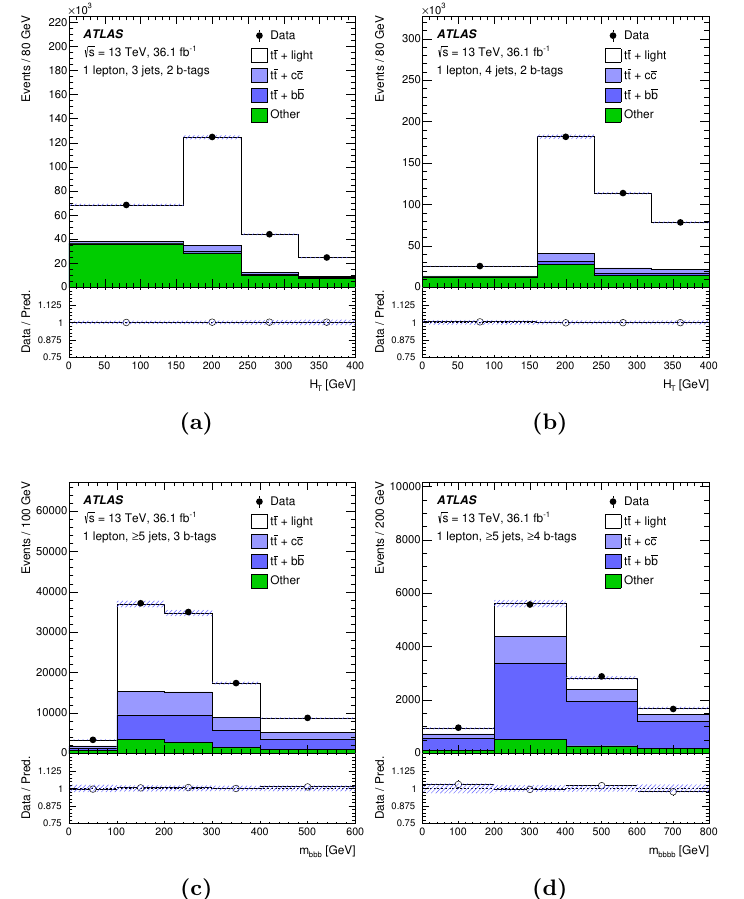
Figure 6. Comparison between data and prediction in the single-lepton control regions of the H T variable for (a) (1 ‘ , 3j, 2b) and (b) (1 ‘ , 4j, 2b) and the invariant mass of b -tagged jets for (c) (1 ‘ , 5j, 3b) and (d) (1 ‘ , 5j, 4b), after the combined single-lepton and dilepton (cid:12)t to the data. The (cid:21) (cid:21) (cid:21) last bin contains the over(cid:13)ow.